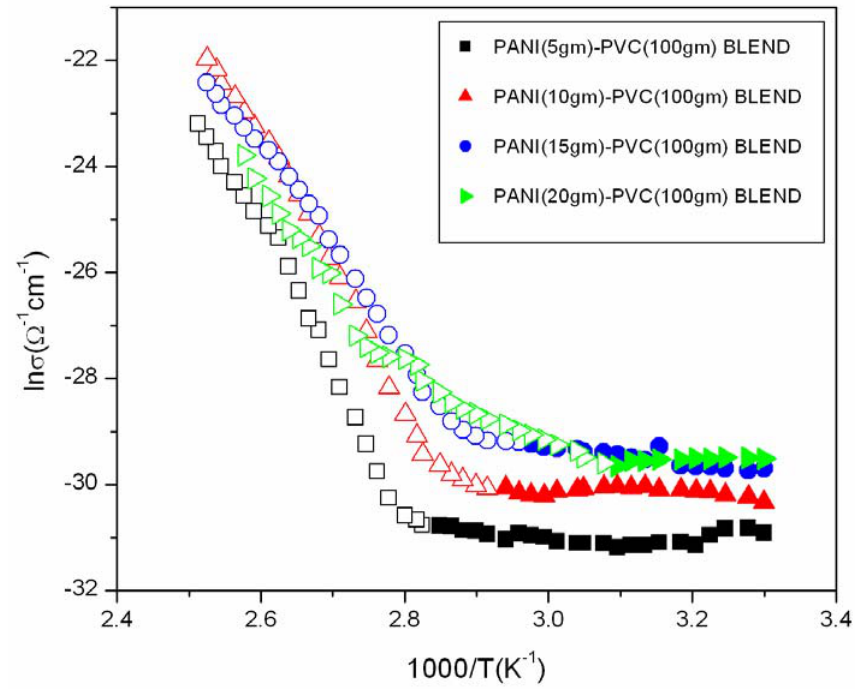
Fig. 5 Variation of dc conductivity with 1000/T for PANI doped with 15 % sulfamic acid in PANI-PVC